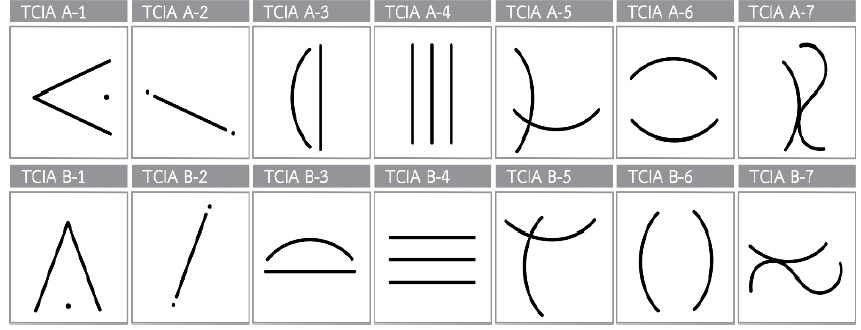
Figure 3. A form The Test of Creative Imagery Abilities (TCIA) by Jankowska and Karwowski